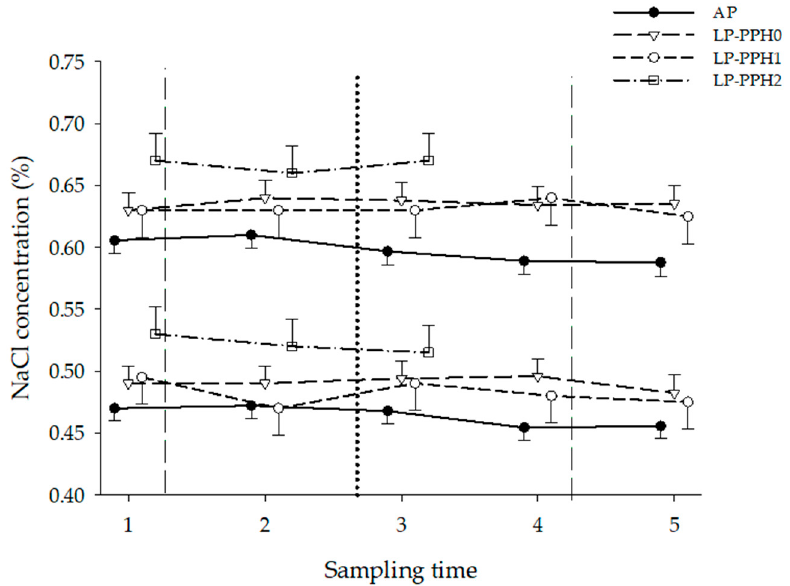
Figure 6. Osmotic resistance of dairy cattle receiving a diet with adequate P content (AP, n = 9) or a P deficient diet (LP, n = 9) in the periparturient period. Concentrations of NaCl solutions at which 10% (upper panel) and 90% (lower panel) of hemolysis occurred at the different blood sampling times. LP-PPH2: cows that developed clinical PPH (i.e., hemoglobinuria; n = 2), LP-PPH1: cows with subclinical PPH (n = 2); LP-PPH0: cows without evidence for PPH (n = 5). The vertical dashed lines mark the beginning and end of the phosphate depletion and repletion phase of the study. The vertical dotted line indicates